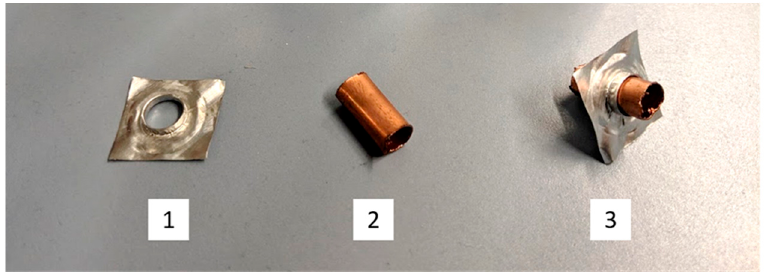
Figure 2. Photograph of metallic (1: aluminum, 2: copper, 3: copper and aluminum) samples which were used for material compatibility experiments.